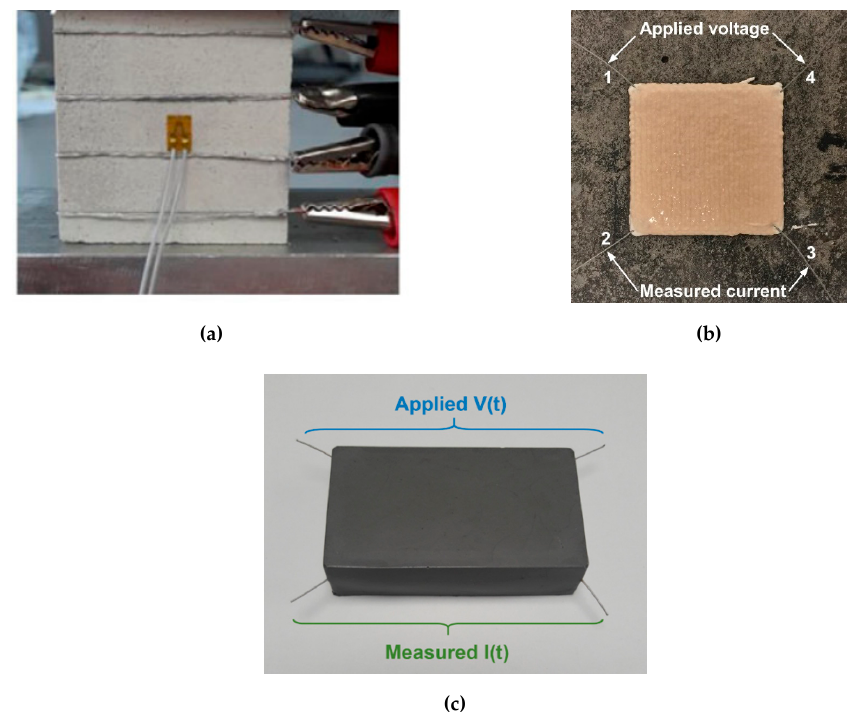
Figure 1. Self-sensing AAM substrates ( a ) metakaolin AAM with wound wires [55] ( b ) metakaolin AAM printed coating with stainless steel wires [27] ( c ) fly ash AAM with stainless steel wires